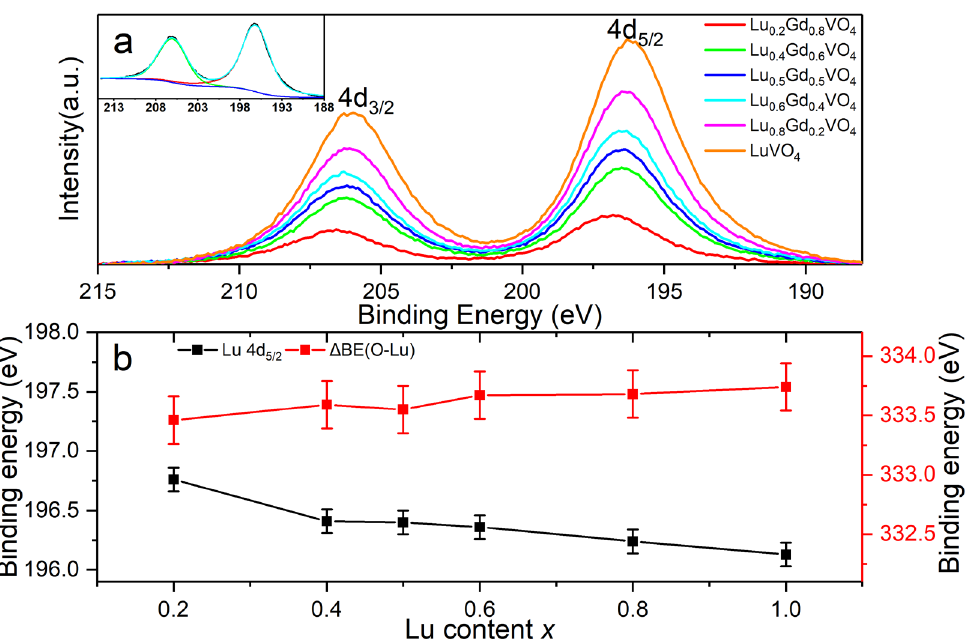
Figure 9. ( a ) Background-subtracted Lu 4 d XPS spectra of Lu x Gd 1 − x VO 4 (0 < x ≤ 1) and the doublet fitting Lu 4 d spectrum of LuVO 4 (inset). ( b ) Binding energy of Lu 4 d 5/2 and the binding energy difference between O 1 s and Lu 4 d 5/2 versus the Lu content x . The error bars are 0.1 and 0.2 eV, respectively.